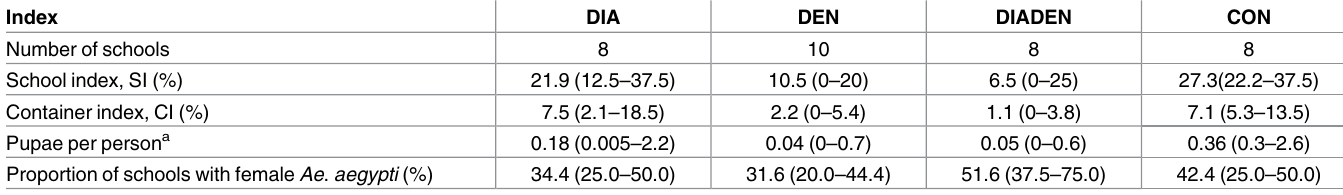
Table 4. Outcomes of entomological indices, values are mean (range) of values over four collection points, in rural primary schools in study arms receiving diarrhea (DIA), dengue (DEN), both (DIADEN), or no intervention (CON) in Anapoima and La Mesa municipalities, Colombia, 2012–